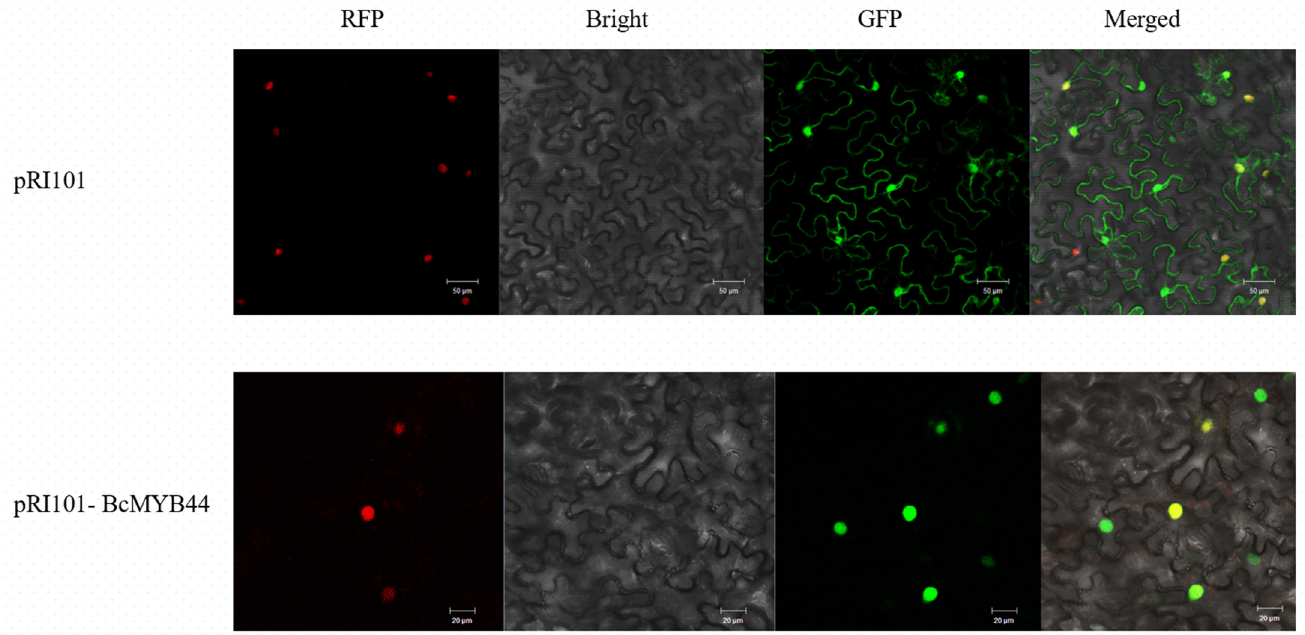
Figure 2. The subcellular localization of BcMYB44 in N. benthamiana leaf cells. (pRI101 for empty vector localization. Scale bars = 50 µ M; pRI101-BcMYB44 for BcMYB44 protein localization. Scale bars = 20 µ M.). RFP: red fluorescence signal under RFP-excited; Bright: Bright field; GFP: green fluorescence signal under GFP-excited light; Merged: superposition of RFP, GFP and bright field.